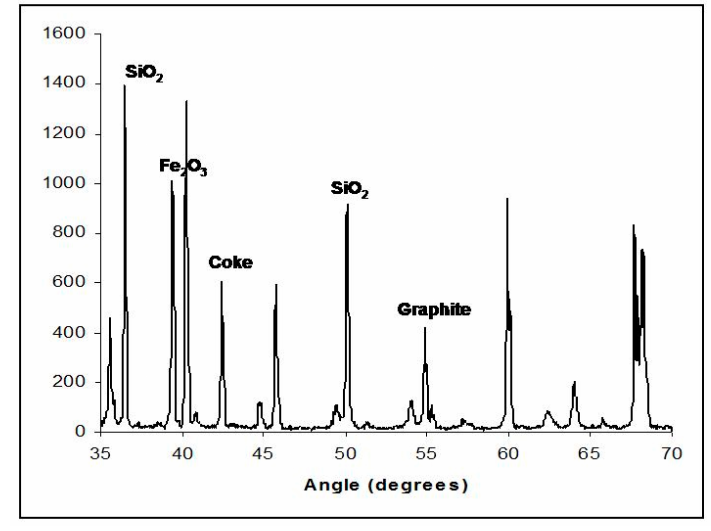
Figure 4. X-Ray Diffraction Analysis of the Fe-20/SiO 2 catalyst after the upgrading reaction (315 °C and 24 h,